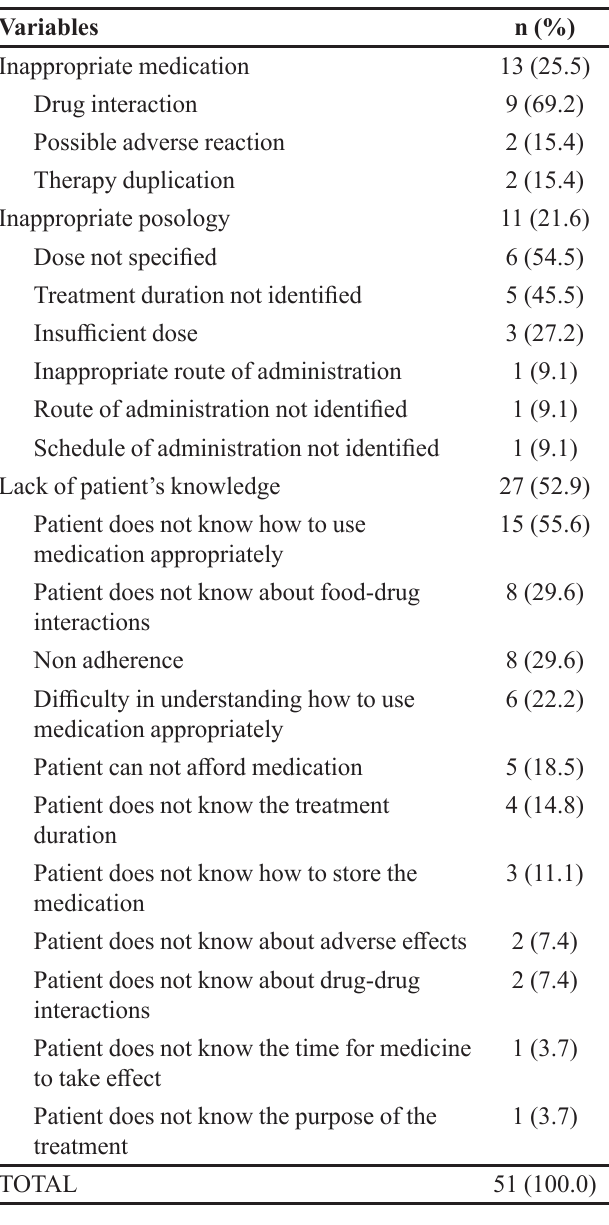
TABLE II - Pharmaceutical interventions performed during the dispensing process at Campus Pharmacy, Goias, Brazil,